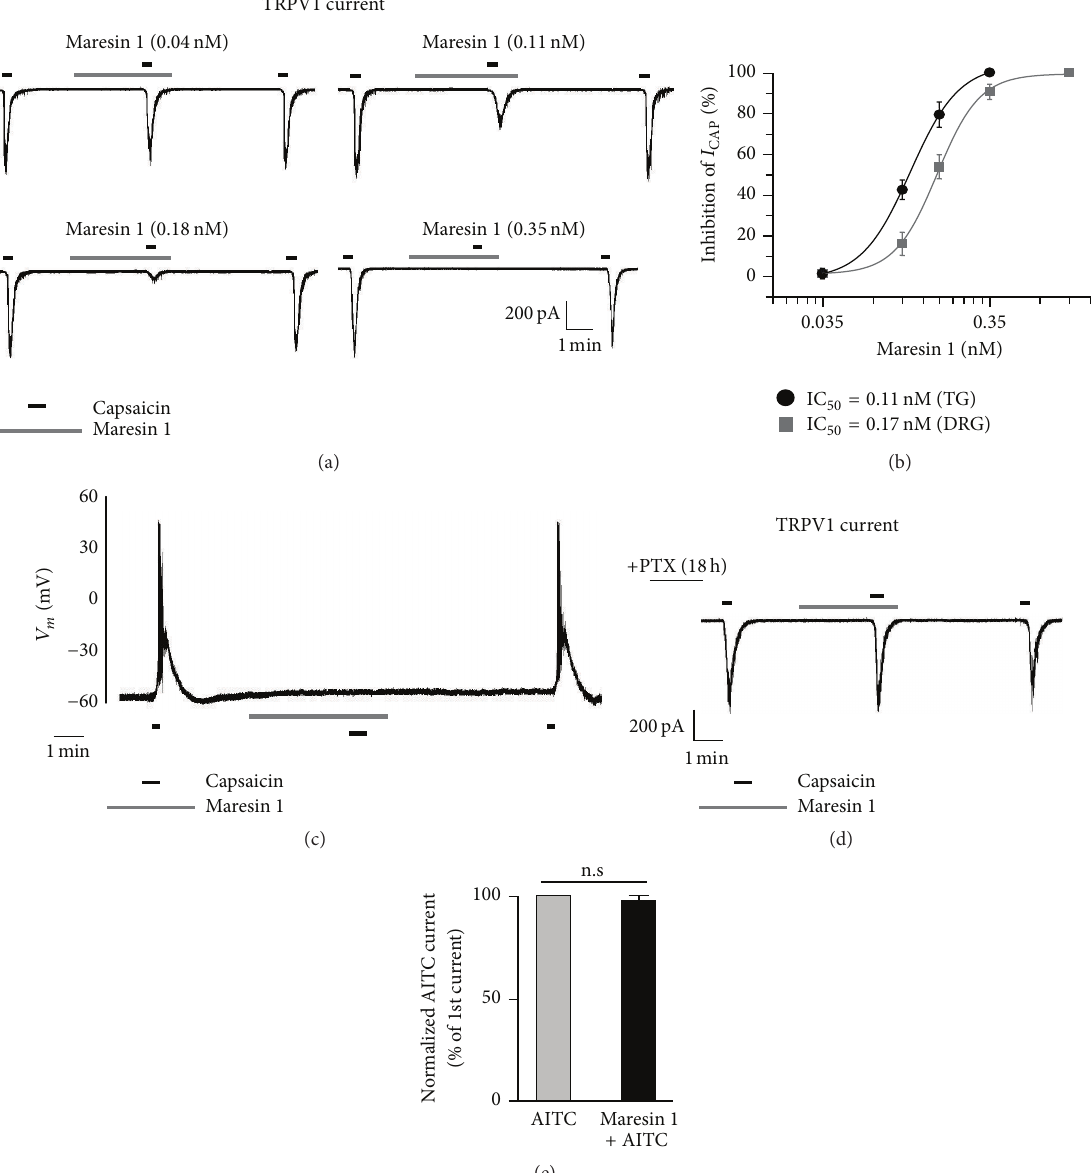
Figure 2: Maresin 1 potently inhibits TRPV1 but not TRPA1 current in DiI-labeled small-sized TG neurons. (a) Voltage-clamp recordings showing dose-dependent inhibition of capsaicin-induced (100 nM) TRPV1 currents by maresin 1 in DiI-labeled small-sized neurons. 𝑛 = 8 for each dose. (b) Dose response curve of maresin 1-induced inhibition of TRPV1 currents in DiI-labeled small-sized neurons (circle, black line) and in small-sized DRG neurons (square, gray line). Inset: IC 50 of TRPV1 current inhibition in TG and DRG neurons, respectively. (c) Current-clamp recording showing blockade of capsaicin-induced action potentials by maresin 1 (0.35 nM), 𝑛 = 15 . (d) PTX pretreatment (0.5 𝜇 g/mL, 18h) abolishes the inhibitory effects on maresin 1 on TRPV1 currents, 𝑛 = 15 . (e) Maresin 1 (0.35 nM) does not inhibit AITC- induced (300 𝜇 M) TRPA1 currents ( 𝑝 > 0.05 and 𝑛 = 15 , 𝑡